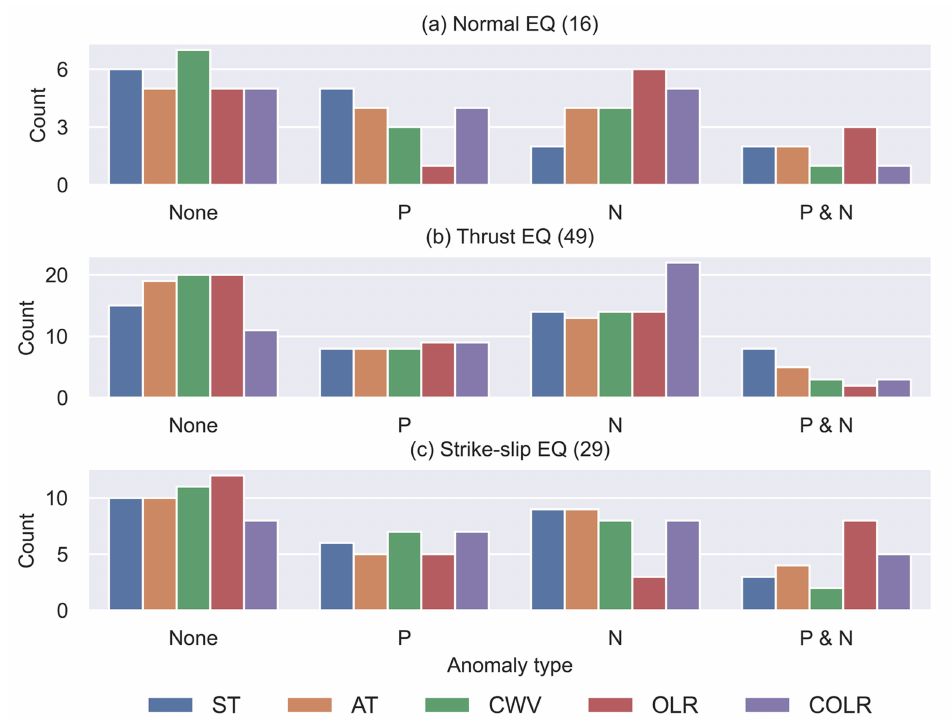
Figure 11. Statistical results of multiparameter temporal integrated anomalies (TIAs) for ( a ) normal, ( b ) thrust, and ( c ) strike-slip earthquakes (EQ). ST, skin temperature; AT, air temperature; CWV, total integrated column water vapor burden; OLR, outgoing longwave radiation; COLR, clear-sky